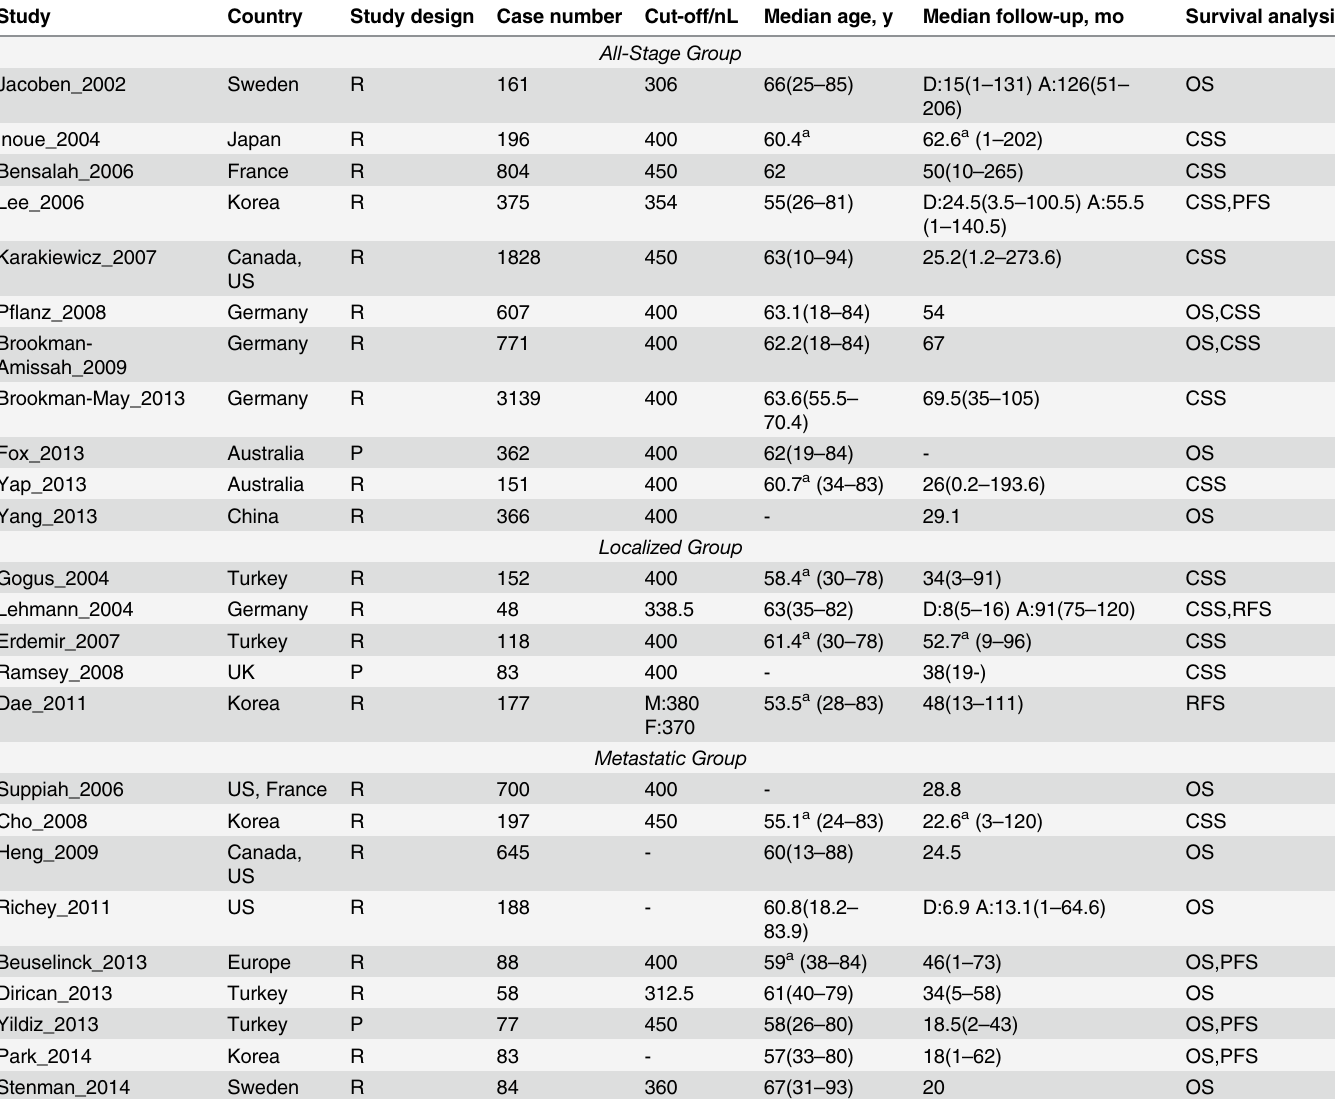
Table 1. Major feature of the included